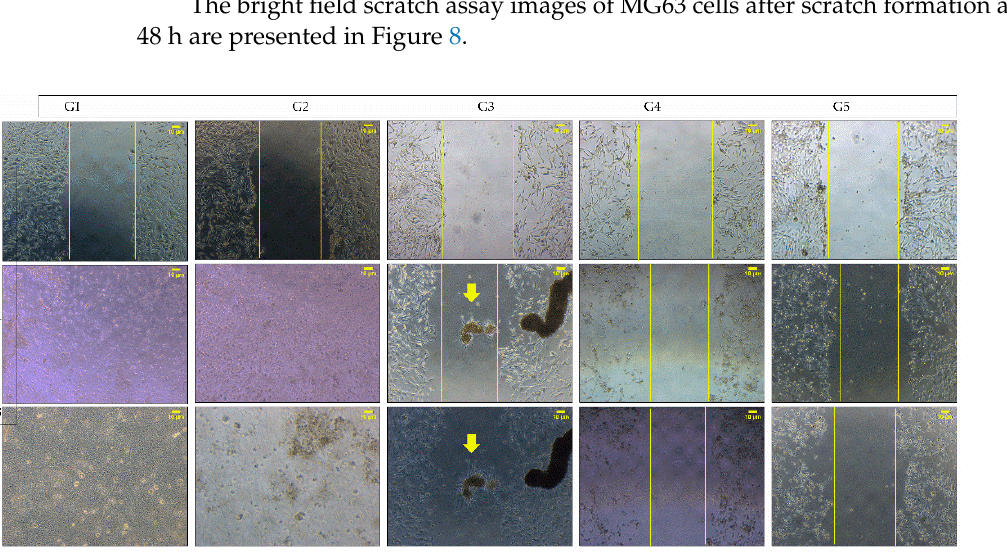
Figure 8. Bright field images of the MG63 scratch assay incubated for 24 h and 48 h in the defined borax content media, and the extracted media from 5 different groups. Group 1: extract from cryogel 100:0 3B; Group 2: extract from cryogel 70:30 3B; Group 3: extract from cryogel 50:50 3B; Group 4: 0.01 mg borax/mL media; Group 5: 0.005 mg borax/mL media. The yellow lines indicate the scratch boundary and cell migration. The arrows indicate the cell aggregates.